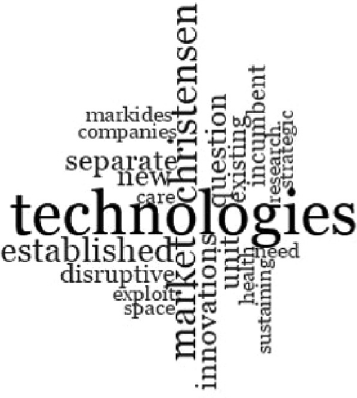
Figure 7. The 12th